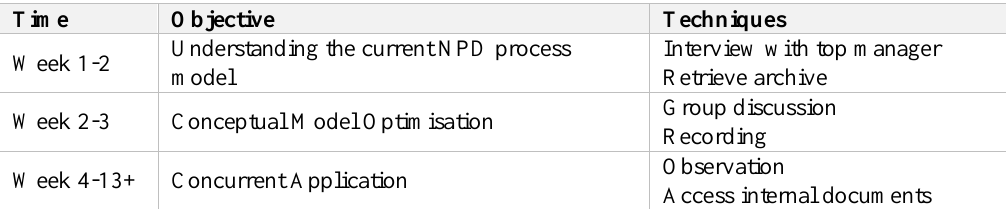
Observation Access internal